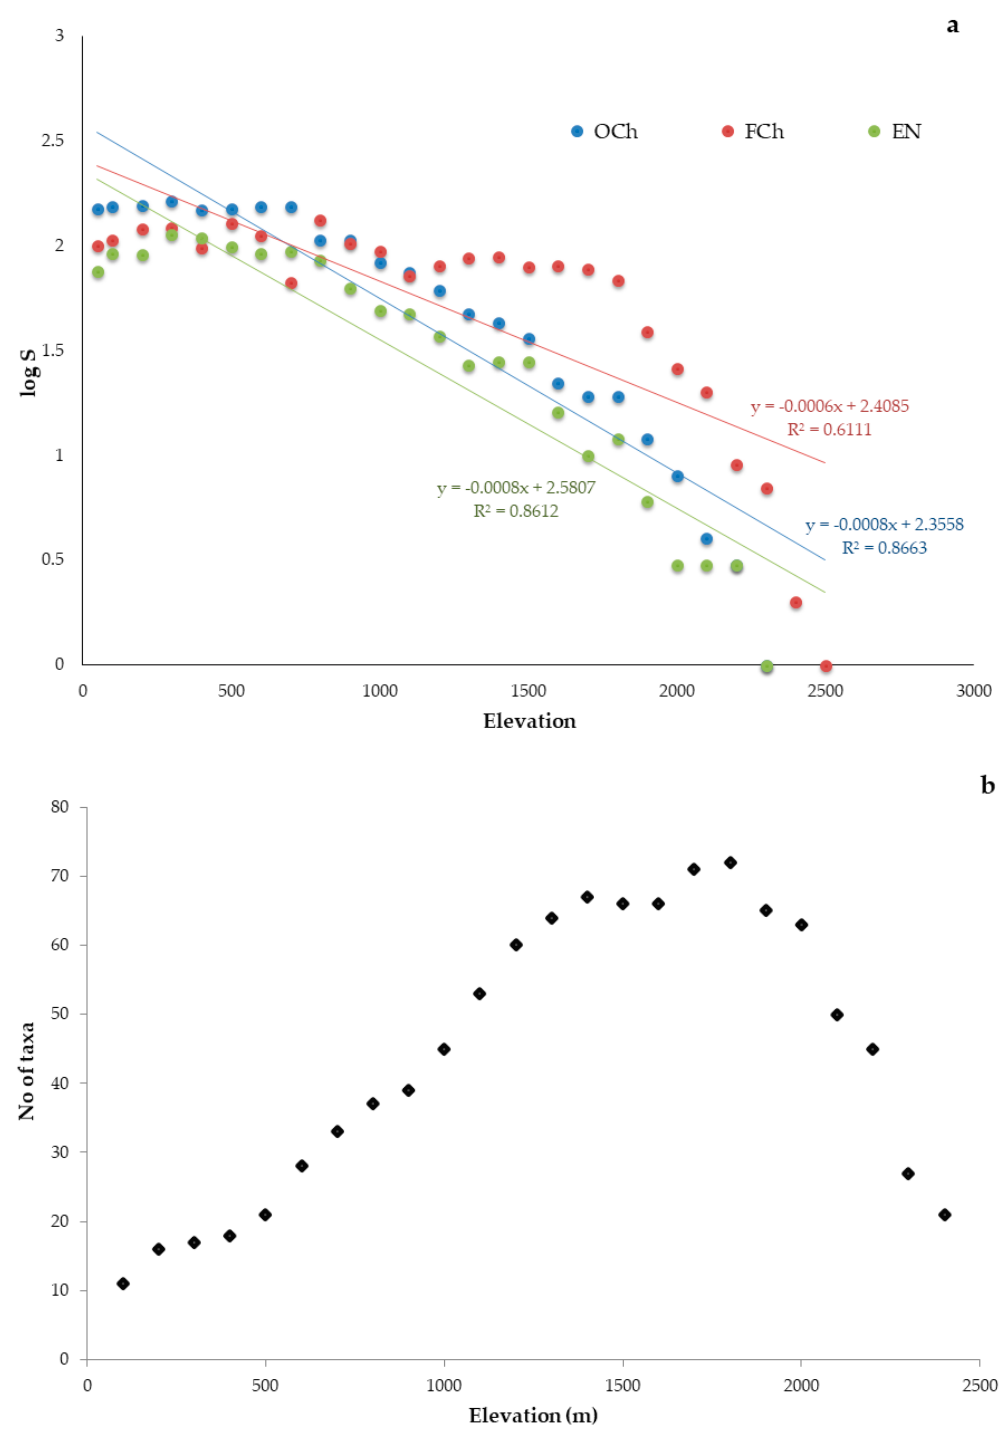
Figure 9. ( a ) Elevational gradient of obligate (OCh), facultative (FCh), and endemic obligate chasmophytes (EN) in the Aegean area. S = number of taxa. Trend lines and equations were set by simple regressions ( p < 0.001) and ( b ) Elevational gradient of obligate chasmophytes (OCh) that are distributed at elevation > 1000 m. Black circles = number of OCh at elevational gradients of 100 m.